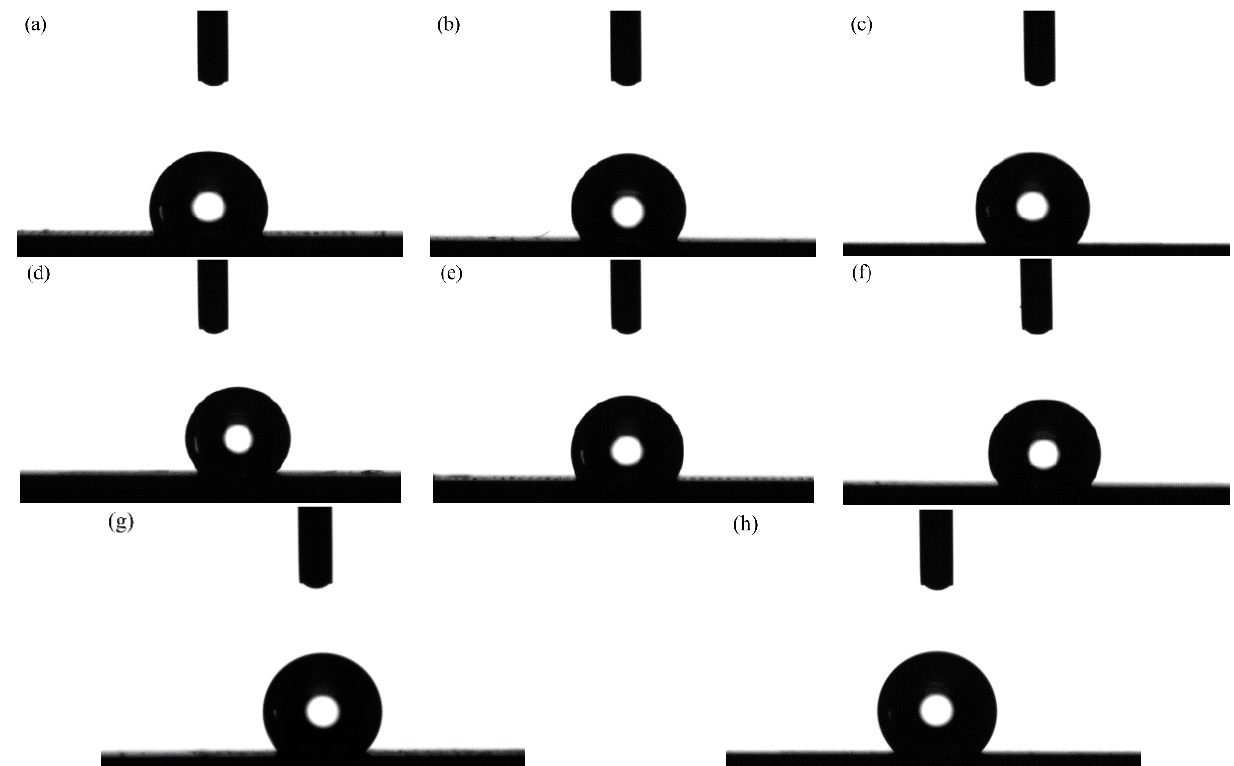
Figure 12. Optical profile of water drops of textured surface with varying pulse width: ( a ) 75 µs, 50 W; ( b ) 100 µs, 50 W; ( c ) 125 µs, 50 W; ( d ) 150 µs, 50 W; ( e ) 75 µs, 60 W; ( f ) 100 µs, 60 W; ( g ) 125 µs, 60 W; ( h ) 150 µs, 60 W.